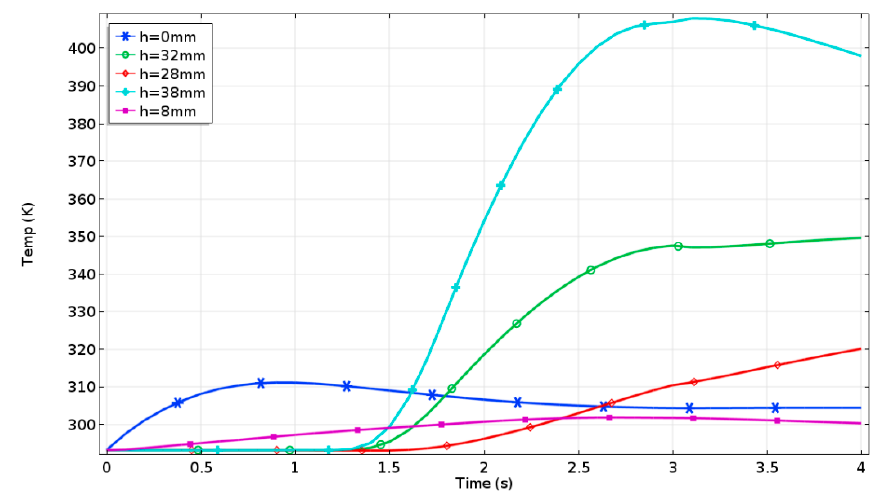
Figure 10. Temperature curves of different axial points of the integrated brake disc.